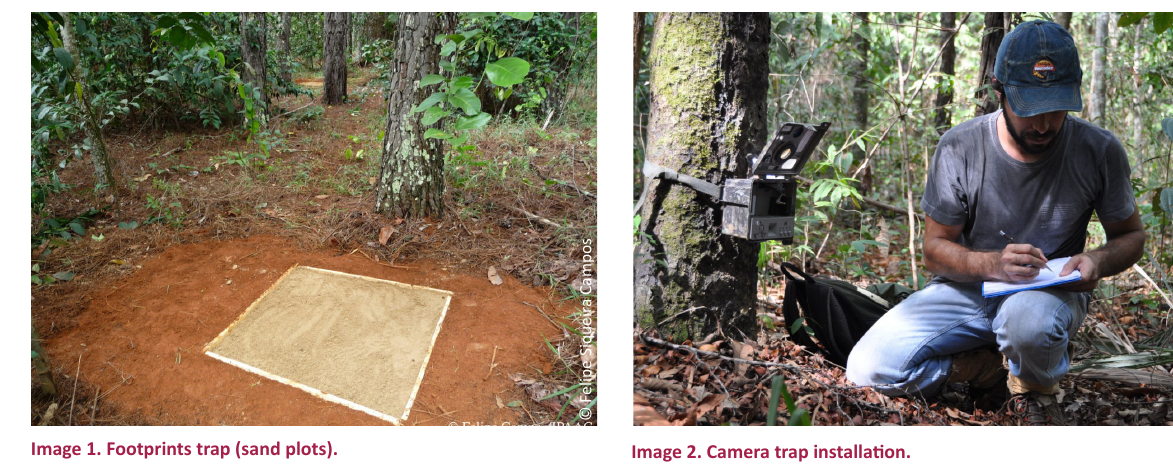
Image 2. Camera trap installation.